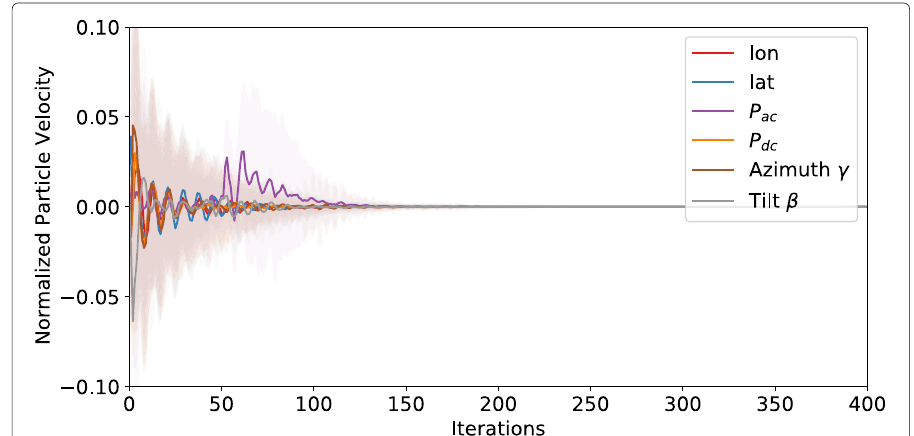
Fig. 5 Mean and standard deviation of velocity history sample run, normalised to the parameter’s search range, using MAE metric